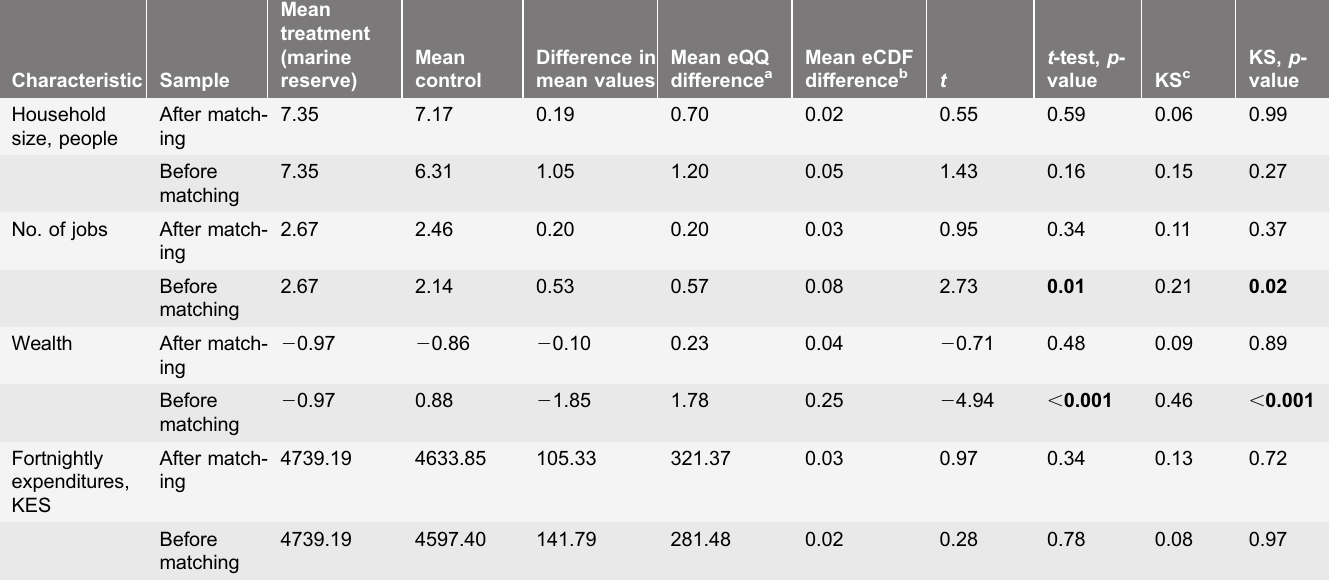
Table 3. Comparison of socio-economic characteristics of Kenyan coastal households near and far from marine reserves, before and after matching.